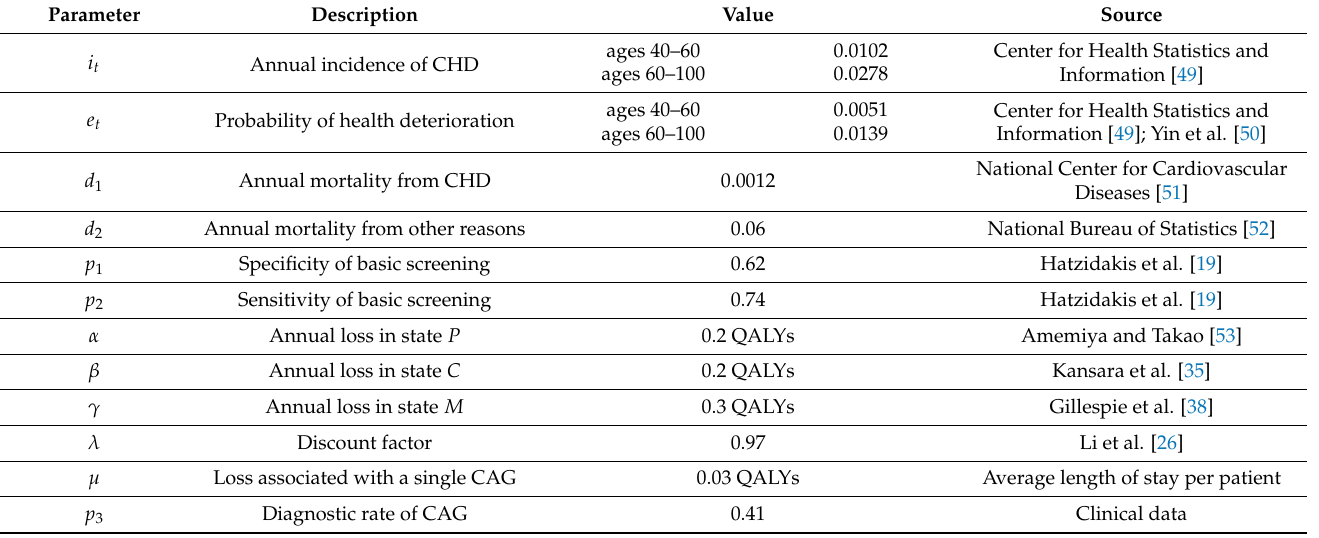
Table 2. Model parameters.